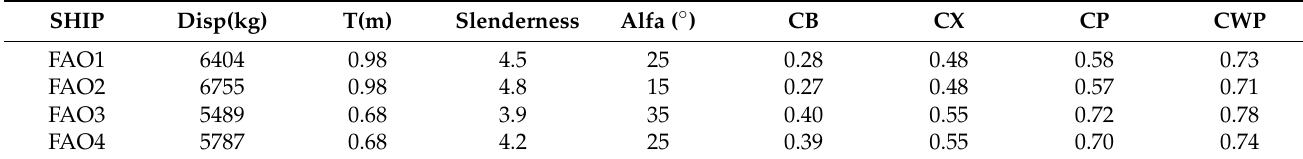
Table 1. Parameters for the models, heavy conditions.